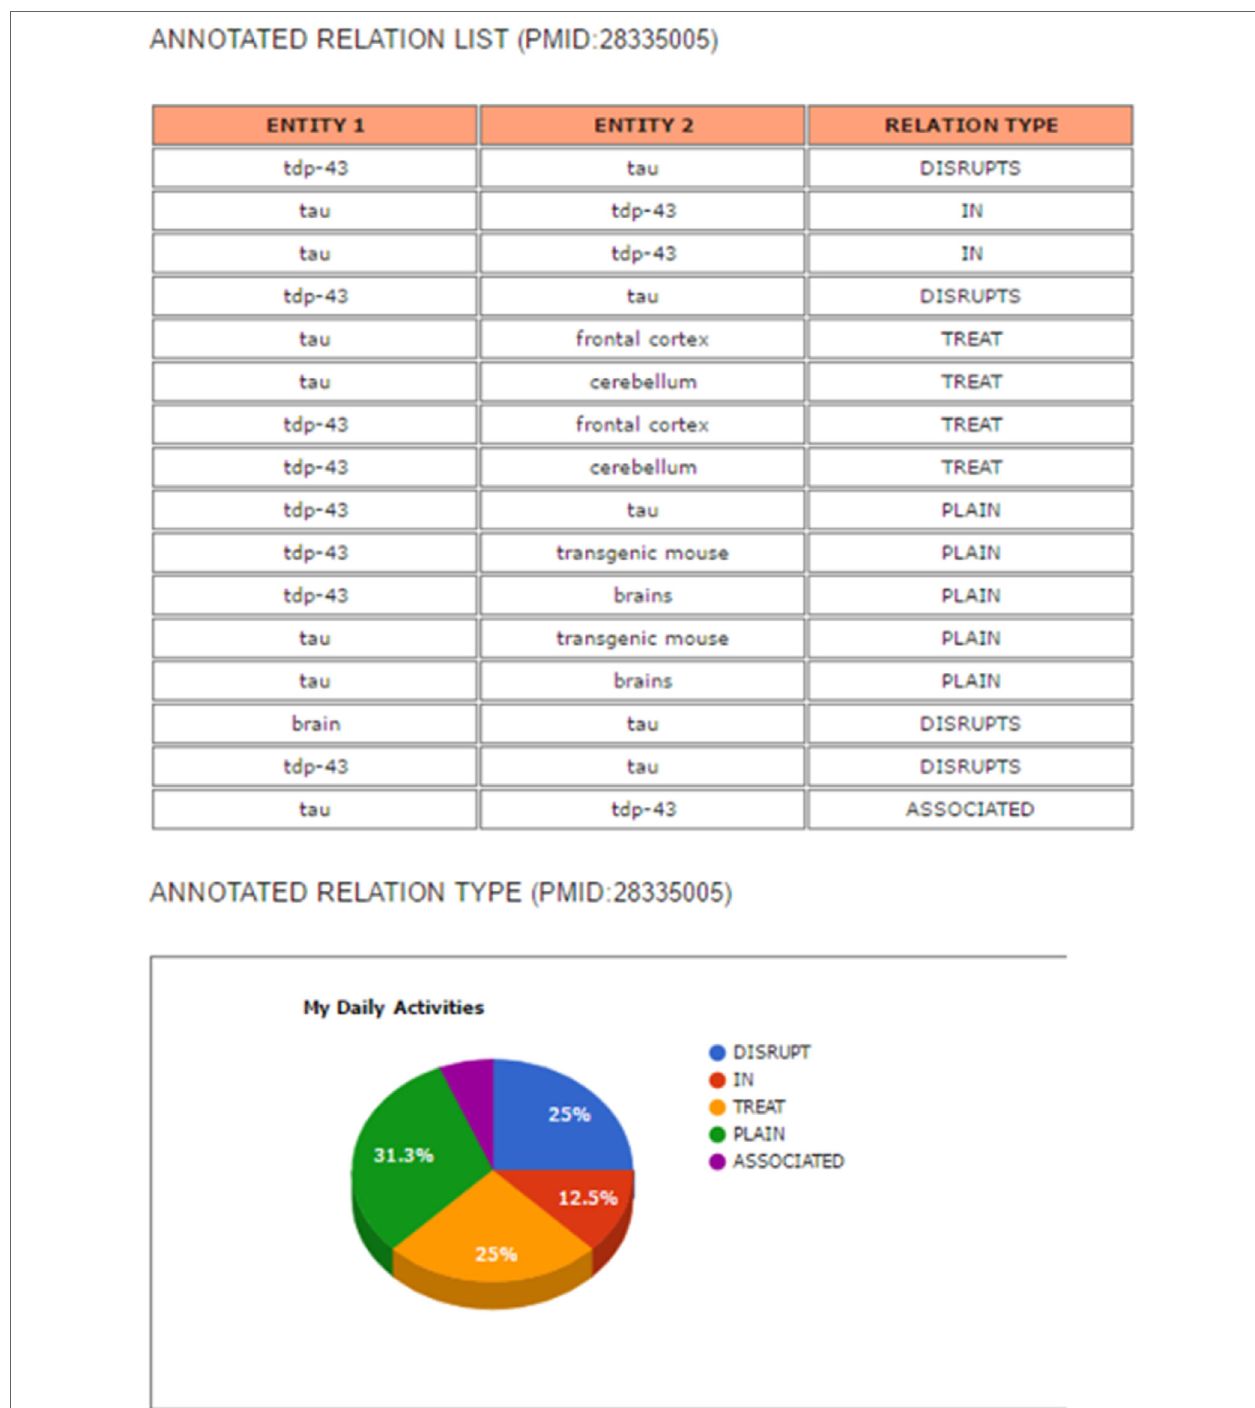
FigUre 11 | Example of the results’ page of search engine: an annotated relation list and a pie chart to show the ratio of annotated relation types.